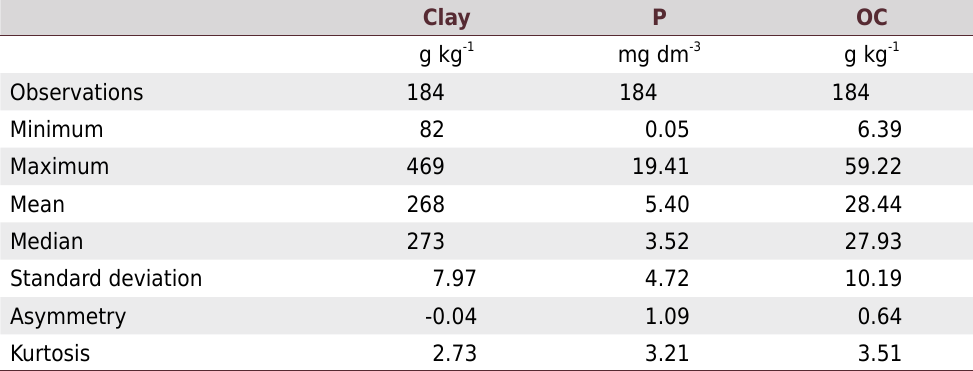
Table 1. Descriptive statistics for the clay, extractable phosphorus (P), and organic carbon (OC) of the all soils Clay P OC g kg -1 mg dm -3 g kg